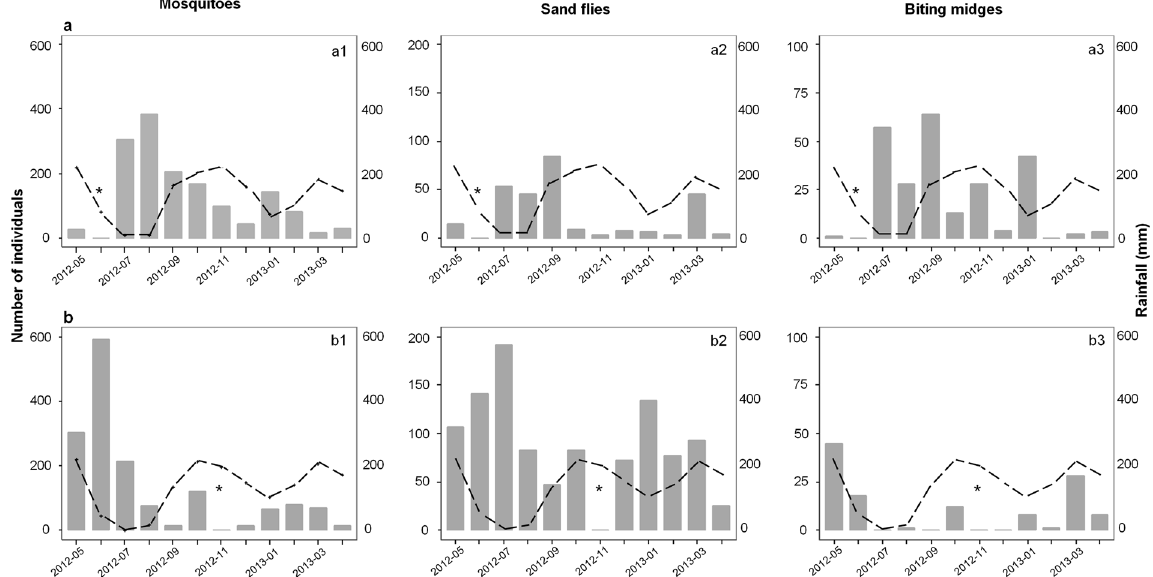
Figure 3. Density variations for each Diptera group along time in Kessipoughou ( a ) and Djibilong ( b ) caves. Histograms (in grey) show the number of individuals for each Diptera group (mosquitoes, sand flies and biting midges) collected each month from May 2012 to April 2013. The monthly rainfall estimates (in mm, broken line) were from the United States Department of Commerce, National Weather Service/Climate Prediction Center (http://www.cpc.ncep.noaa.gov/products/fews/africa). * Month without sampling.